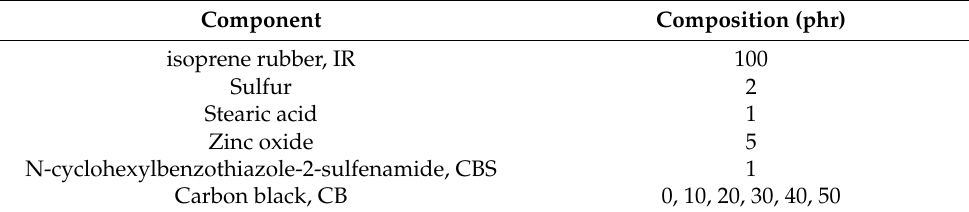
Table 1. Formulation of the CB-reinforced isoprene rubber.